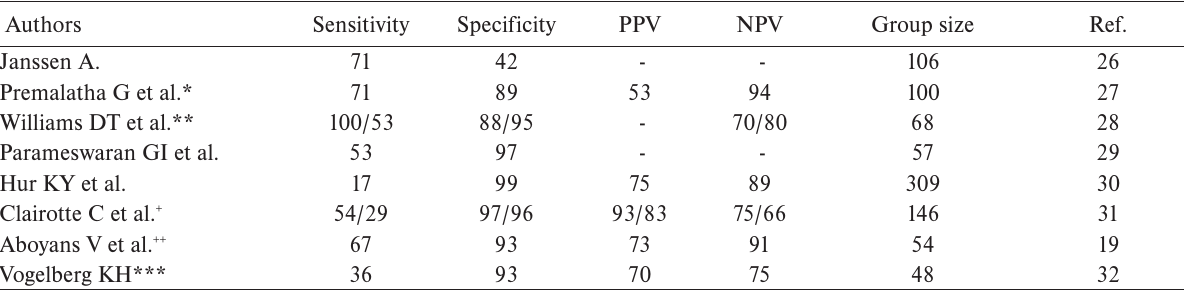
Table 4. Test parameters for ABI use for screening of